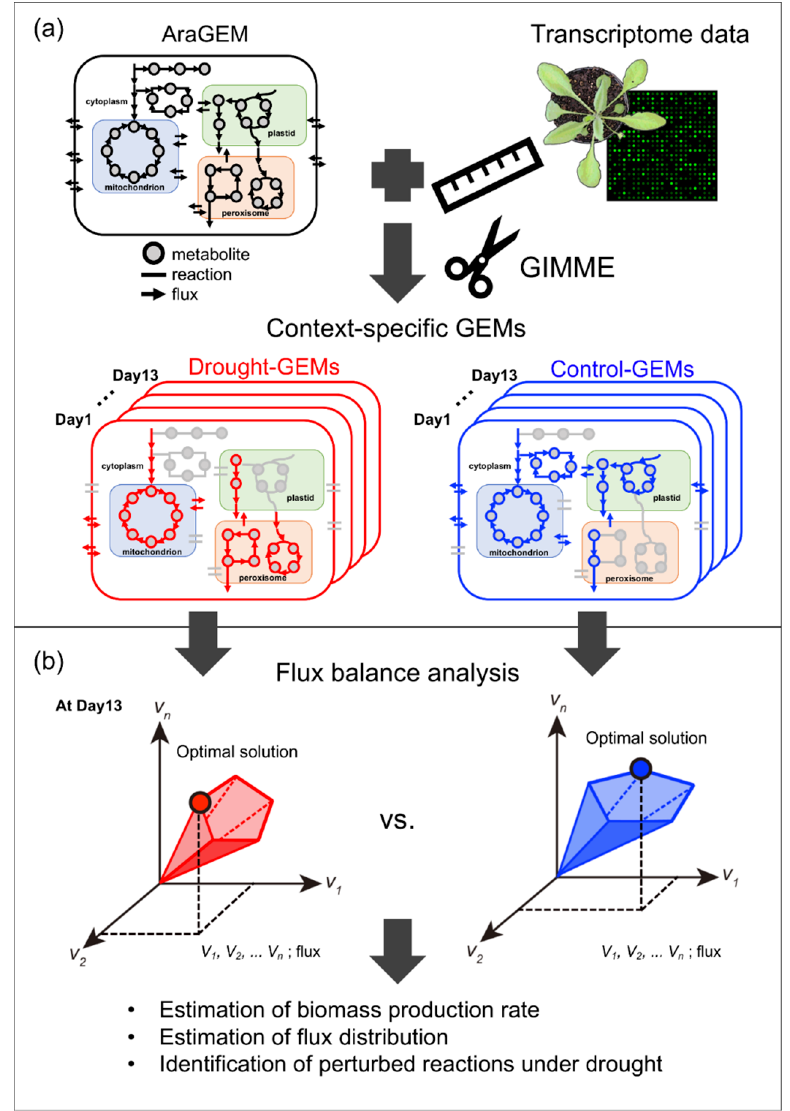
Figure 1. Outline of this study for extracting information for the metabolic network by reconstructing context-specific genome-scale metabolic models (GEMs): ( a ) Transcriptome data were used to tailor the global GEM of A. thaliana and to obtain context-specific GEMs under progressive drought treatment (days 1–13). ( b ) Using flux balance analysis (FBA), the biomass production rate and flux distribution were estimated. Comparative analysis of the flux distribution between drought and control conditions was performed to identify candidate reactions associated with adaptation to drought. Drought and control GEMs are colored in red and blue, respectively. The eliminated reactions and metabolites are shown in grey. Examples of optimal solutions for flux distribution that lies on the border of the feasible space are represented by red and blue dots for drought and control GEMs, respectively.